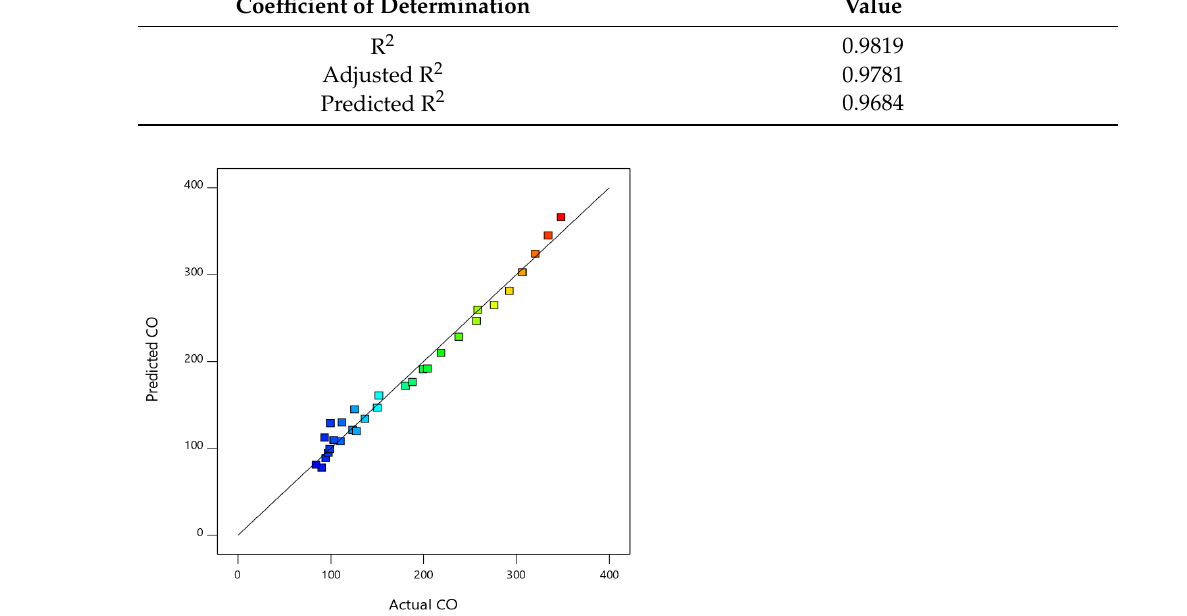
Figure 6. Comparison of actual and predicted CO.